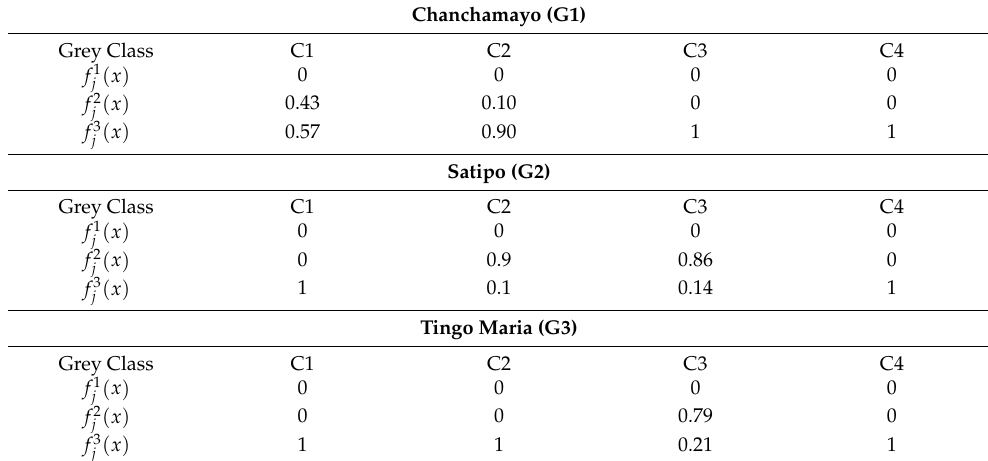
Table 8. Values of the functions evaluated in the groups.